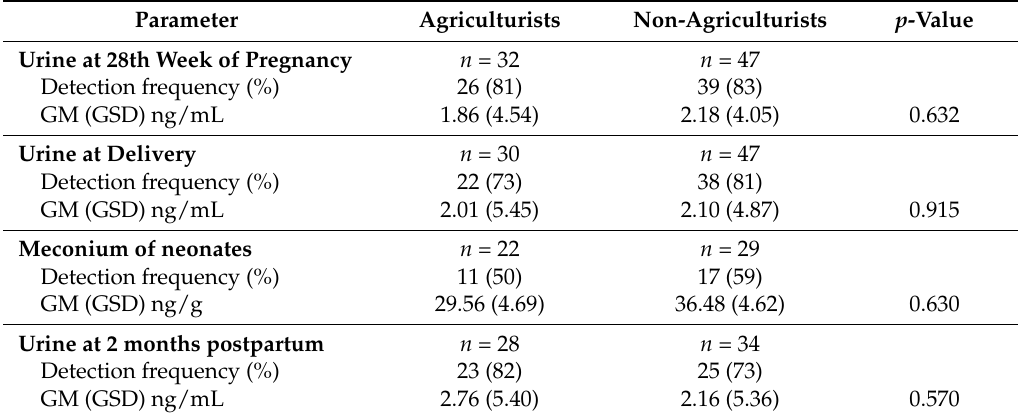
Table 3. Urinary paraquat concentrations at three time points: 28th weeks of pregnancy, delivery and 2 months postpartum and paraquat concentrations in meconium of